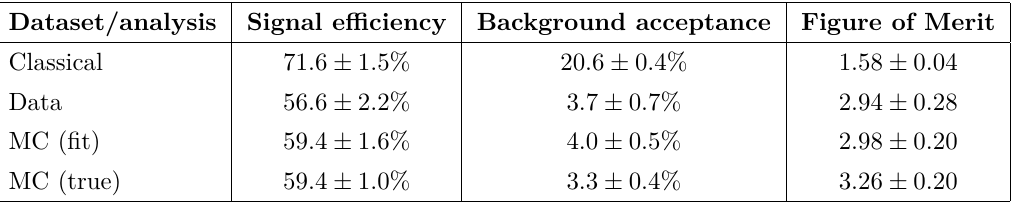
Table 1 . Signal efficiency and background acceptance for the optimal figure of